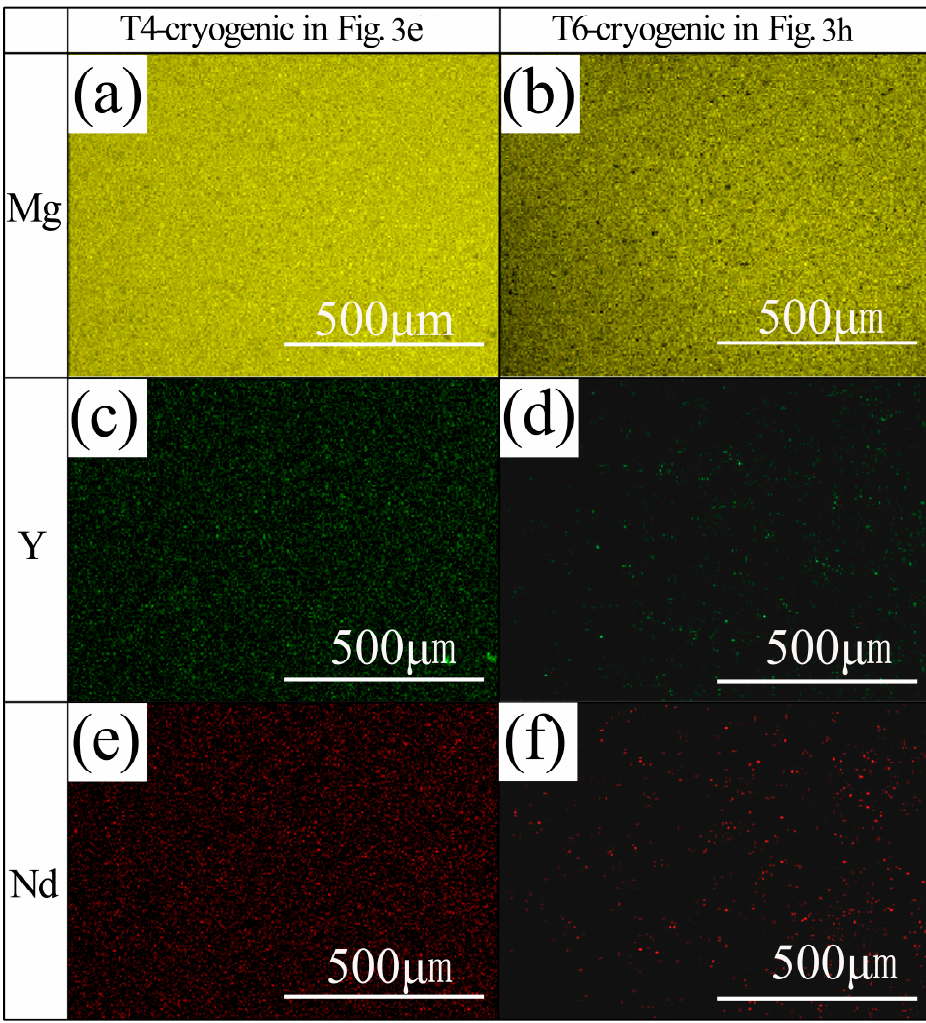
Figure 7. The corresponding elemental distributions of samples after cryogenic quenching: ( a ) T4-magneisum; ( b ) T6-magneisum; ( c ) T4-yttrium; ( d ) T6-yttrium; ( e ) T4-neodymium; and ( f ) T6-neodymium.